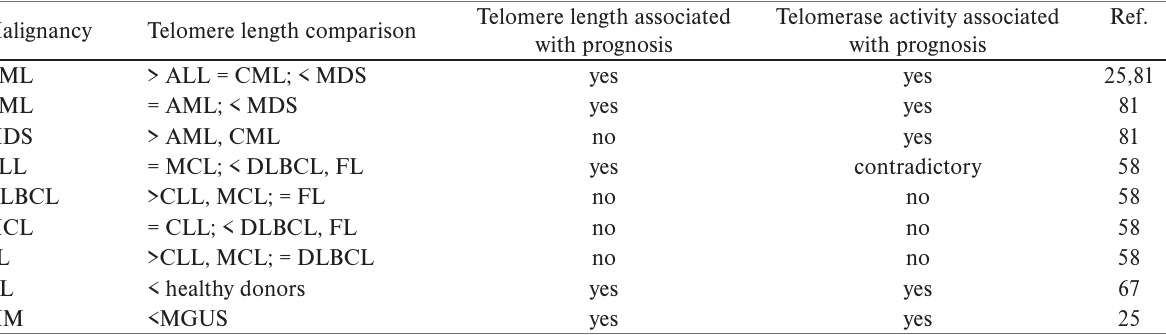
Table 1. Comparison of telomere length and telomerase activity and their association with disease prognosis in hemato-oncolog- ical